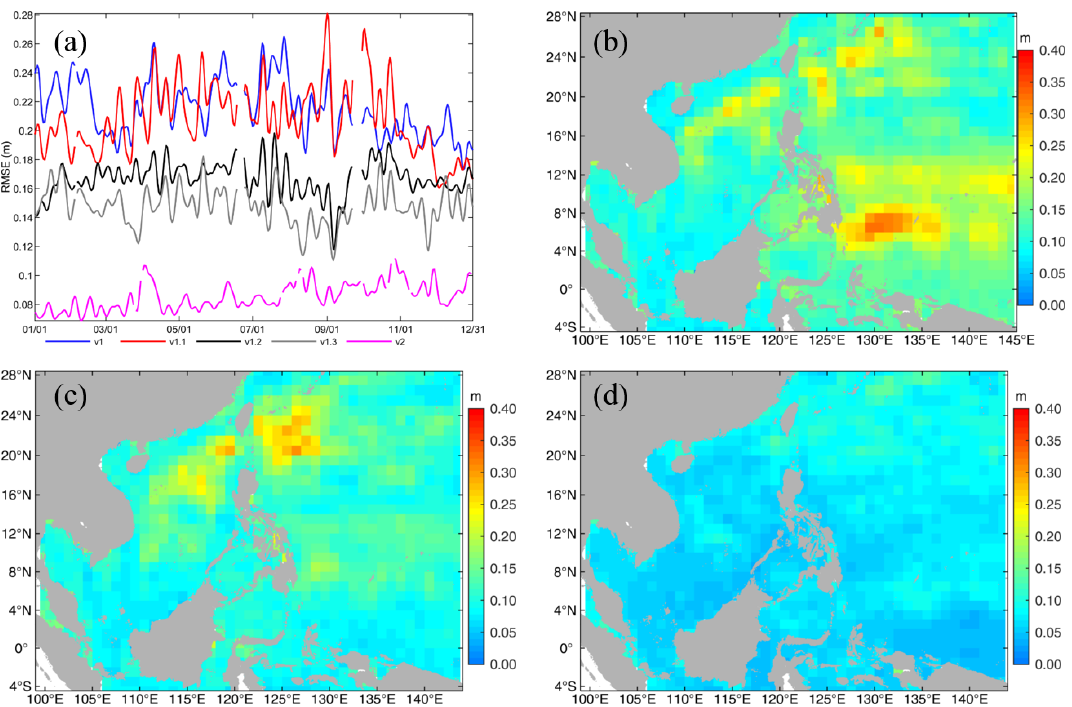
Figure 11. Panel (a) is similar to Fig. 10b but for the SLA. Panels (b–d) are similar to Fig. 10c and d but for the SLA of v1, v1.3 (in 2013), and v2,